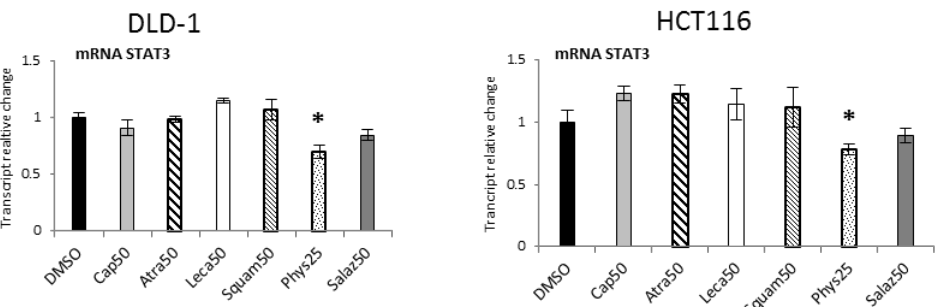
Figure 11. The effect of lichen-derived compounds on the expression of STAT3 in DLD -1 and HCT116 cells. The values cells. The values (fold of control) are presented as the means ± SEM from three separate experiments. (fold of control) are presented as the mean s ± SEM from three separate experiments. Asterisks (*) denote statistically sig- Asterisks (*) denote statistically significant changes from the control group ( p ≤ 0.05). DMSO , vehicle nificant changes from the control group ( p ≤ 0.05). DMSO , vehicle control; Cap50 , caperatic aci d (50 µM); Atra50 , atranorin control; Cap50 , caperatic acid (50 µ M); Atra50 , atranorin (50 µ M); Leca50 , lecanoric acid (50 µ M); (50 µM); Leca50 , lecanoric acid (50 µM); Squam50 , squamatic acid (50 µM); Phys25 , physodic acid (25 µM); Salaz50 , sal- Squam50 , squamatic acid (50 µ M); Phys25 , physodic acid (25 µ M); Salaz50 , salazinic acid (50 µ azinic acid (50 µM).